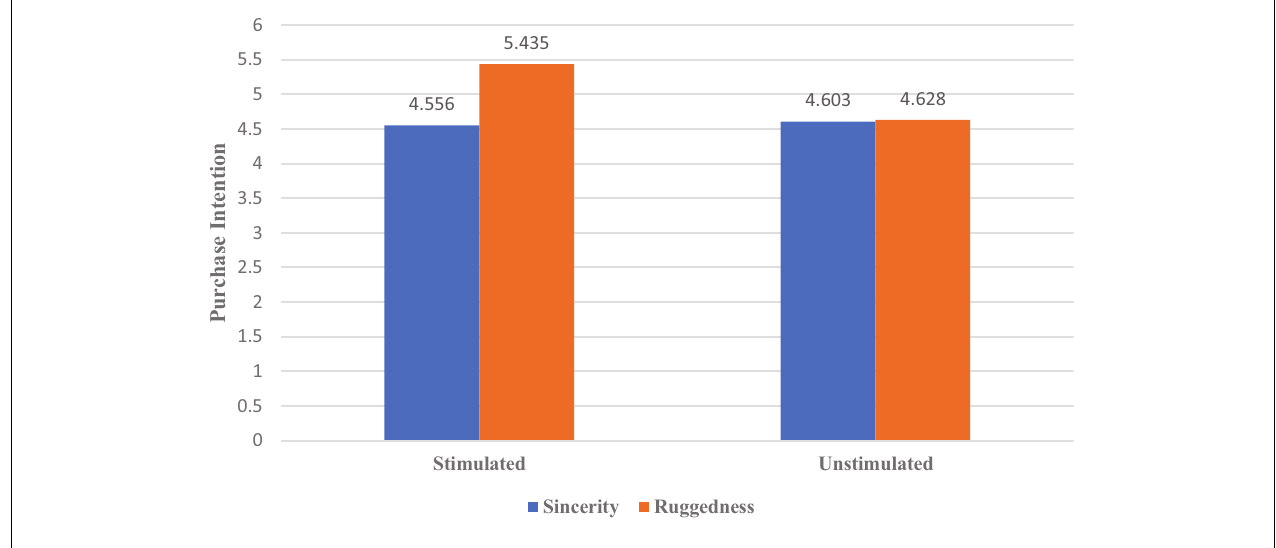
FIGURE 2 | The effect of erotic stimulation on men’s preference for brand personality.